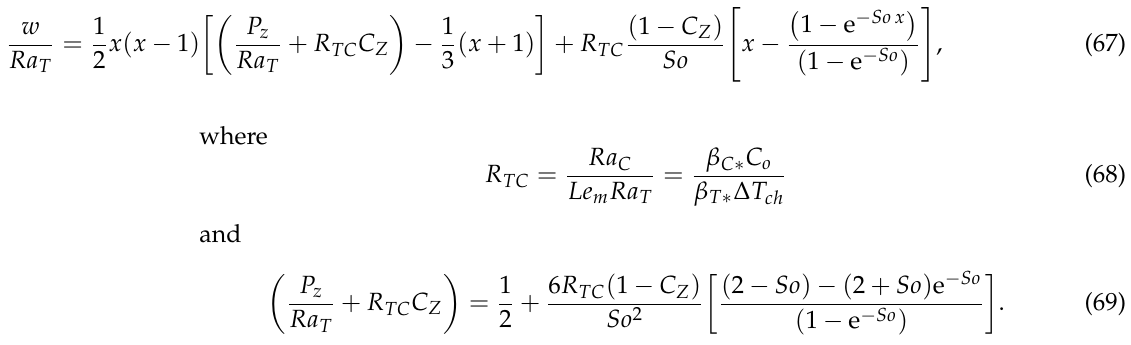
The limit of Equation (69) as So → ∞ is simply obtained in the form: